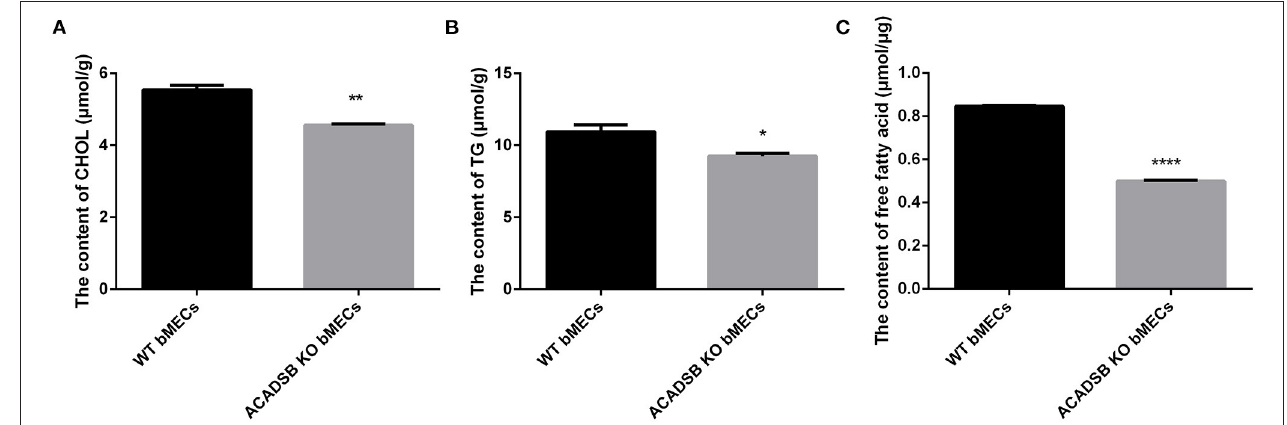
FIGURE 2 | The effect of ACADSB on TGs, CHOL and FFA contents in bMECs. (A) The CHOL content in ACADSB − / − bMECs was decreased compared with that in the WT bMECs. (B) The TG content was lower in ACADSB − / − bMECs compared with that in the WT bMECs. (C) The content of FFA was also significant inhibited in ACADSB − / − bMECs than in the WT bMECs (Experimental data are shown as mean ± SEM). **** P < 0.0001, ** P < 0.01, * P < 0.05.